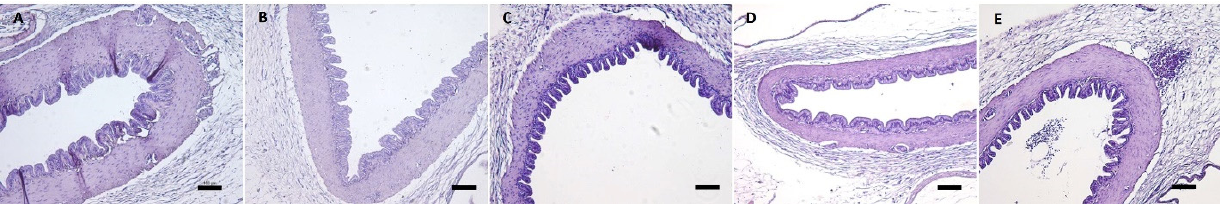
Figure 10. Dissected salmon showing the inner organs with normal aspect. No internal or external haemorrhages or le- sions, nor alterations in the swim bladder were detected. Figure 11. Swim bladder with normal aspect of salmon at different samplings times . ( A ) Control. ( B ) 1 week after exposure. ( C ) 2 weeks after exposure. ( D ) 3 weeks after exposure. ( E ) 4 weeks after exposure. Scale bar: 100 µm.